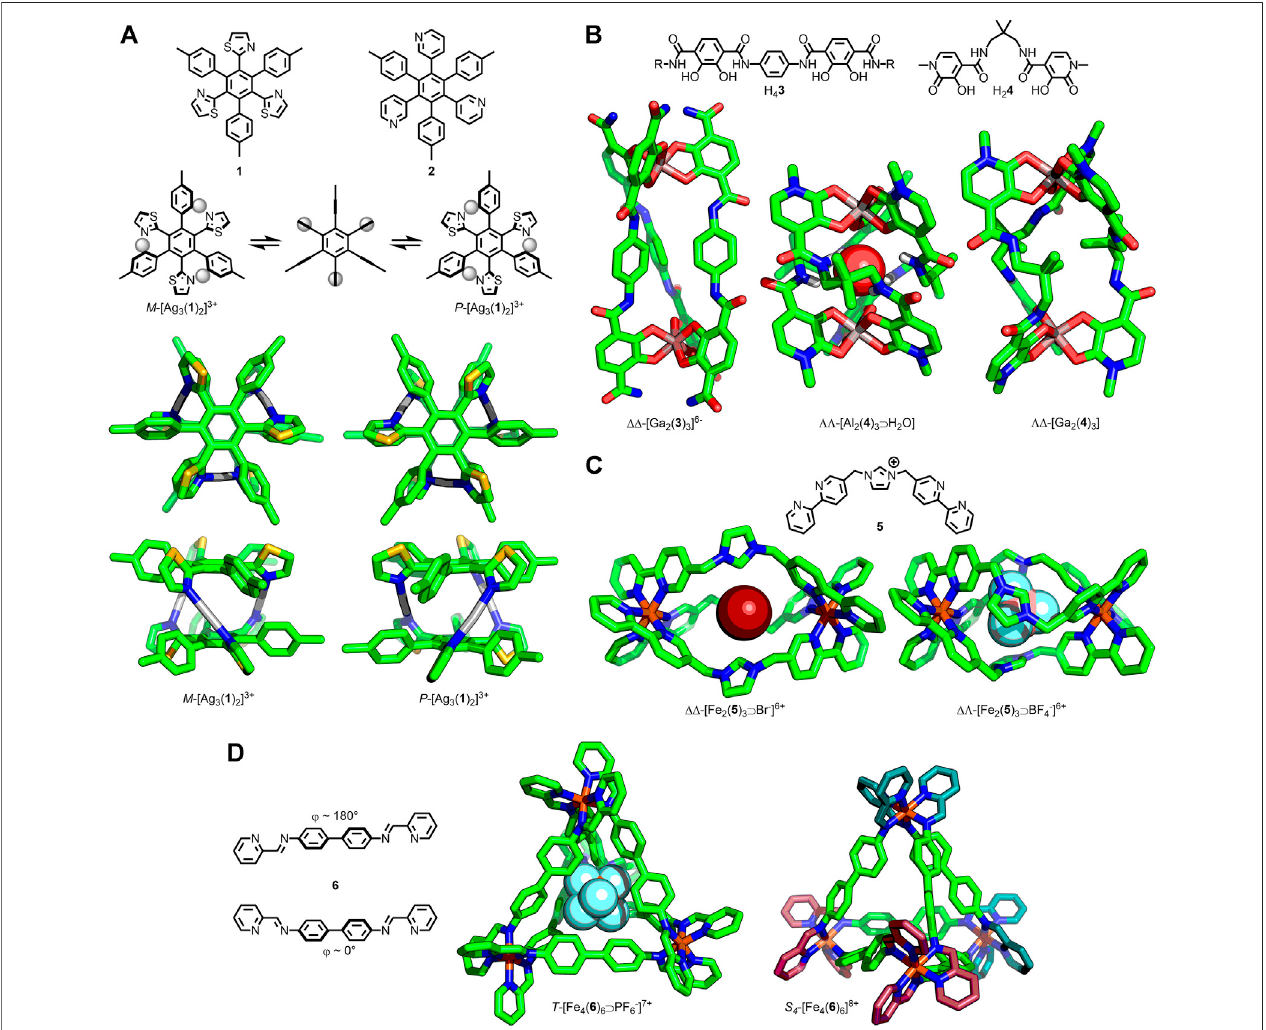
FIGURE 1 | (A) Shionoya ’ s trinuclear P / M -[Ag 3 ( 1 / 2 ) 2 ] 3+ helicates capable of undergoing stereochemical inversion via an achiral intermediate. (B) Raymond ’ s [Ga 2 ( 3 ) 3 ] helicate able to undergo helical inversion via a Bailar twist mechanism; SCXRD structures of [Al 2 ( 4 ) 3 L H 2 O] helicate and [Ga 2 ( 4 ) 3 ] mesocate. (C) Wu ’ s triply- stranded [Fe 2 ( 5 ) 3 L X − ] 6+ assemblies with encapsulated anion-dependent formation of helicate (X − (cid:2) Br − ) or mesocate (X − (cid:2) BF 4 − ) structures. (D) Nitschke ’ s [Fe 4 ( 6 ) 6 ] 8+